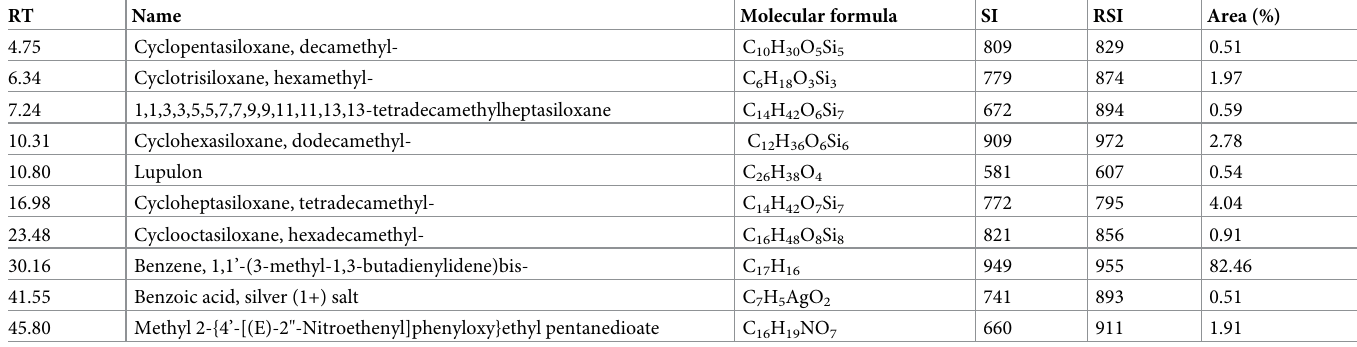
Table 2. SPME-GC-MS analysis of methanol extract of Flavobacterium sp . biomass. SI, direct matching factor, RSI; reverse search matching